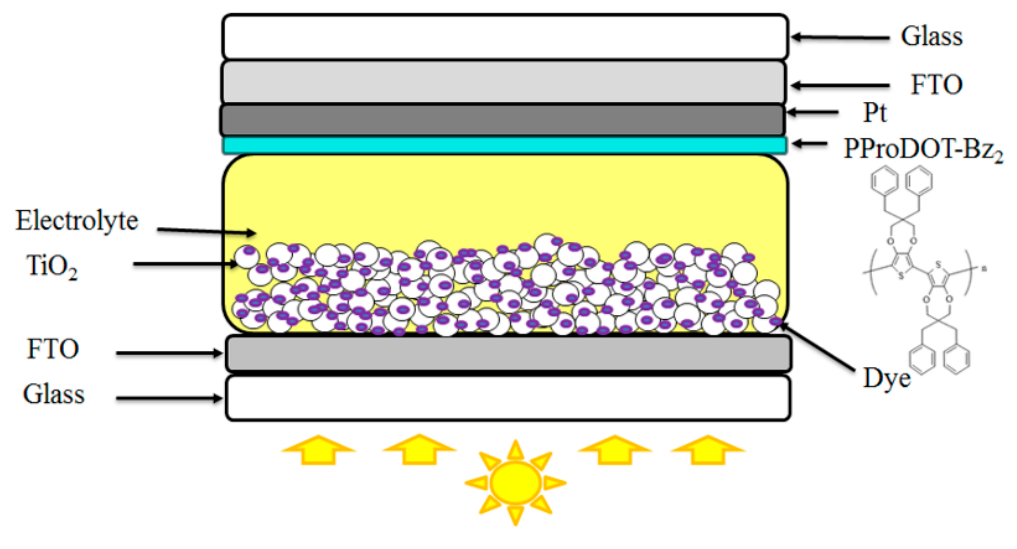
Figure 1. The structure of dye-sensitized solar cells.